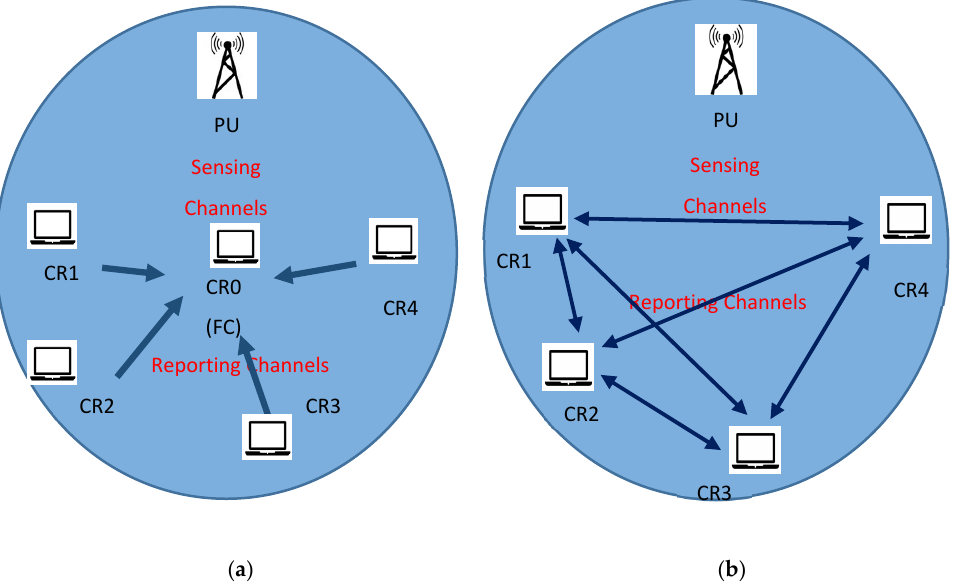
Figure 2. Cooperative spectrum sensing (CSS): ( a ) centralised; and ( b ) distributed.